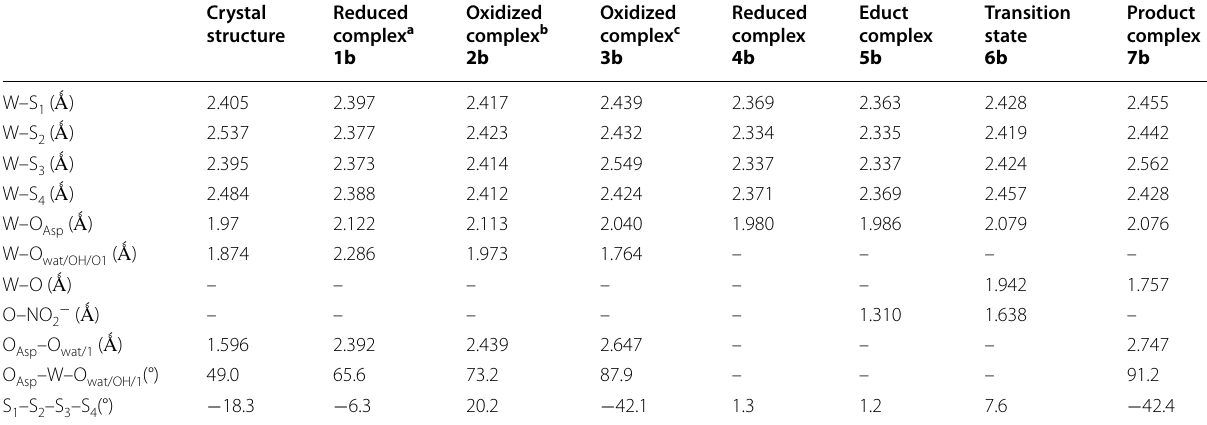
a Water containing reduced complex b Hydroxide containing oxidized complex c Oxygen containing oxidized